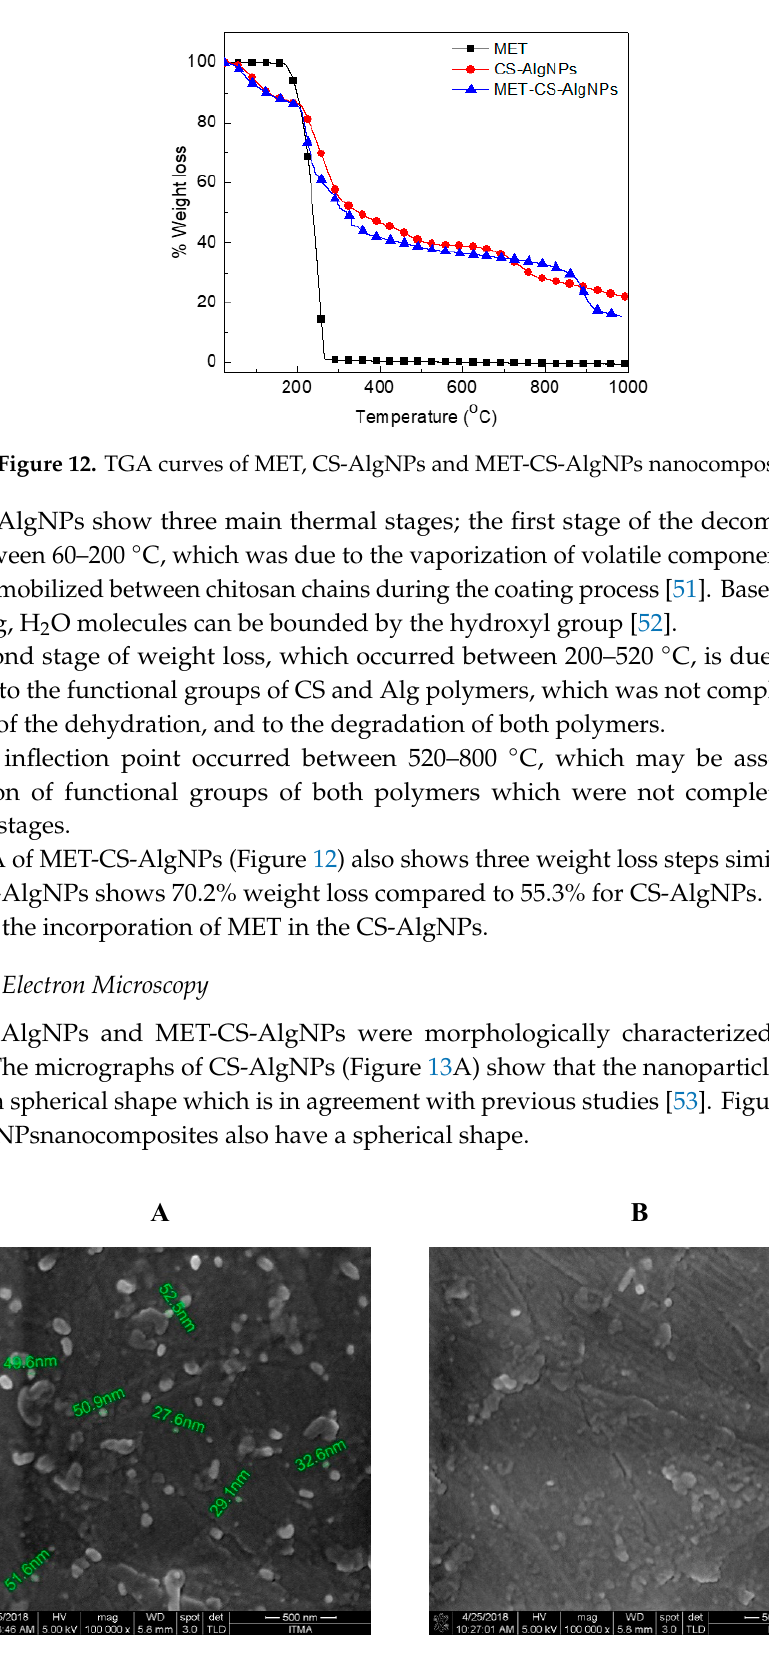
Figure 13. SEM micrographs of CS-AlgNPs ( A ) and MET-CS-AlgNPs ( B )(100000×).